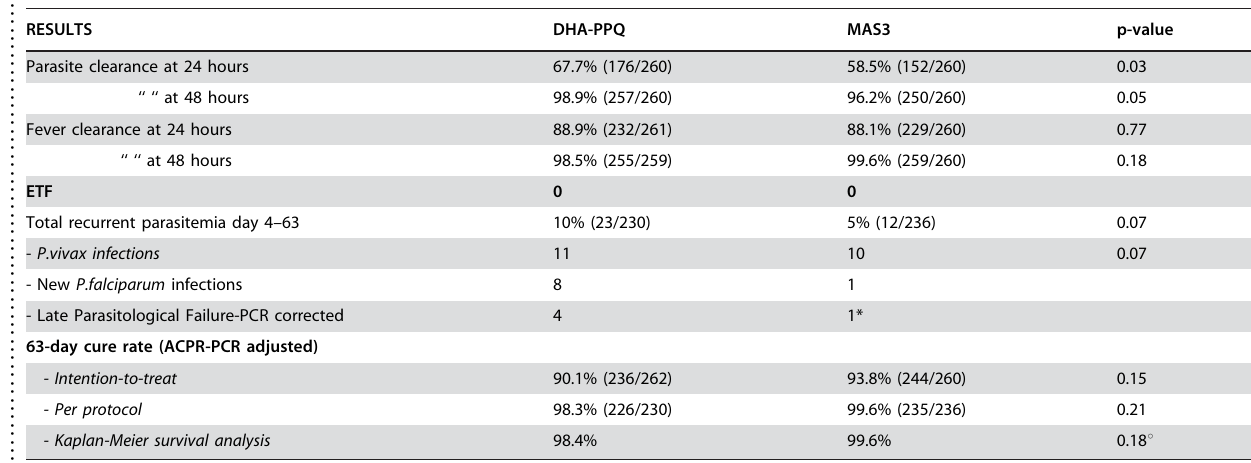
Table 2. Clinical and parasitological outcomes by treatment group. .. ... .... ... ... .... ... ... .... ... ... .... ... ... .... ... ... .... ... ... .... ... ... .... ... ... .... ... ... .... ... ... .... ... ... .... ... ... .... ... ... .... ... ... .